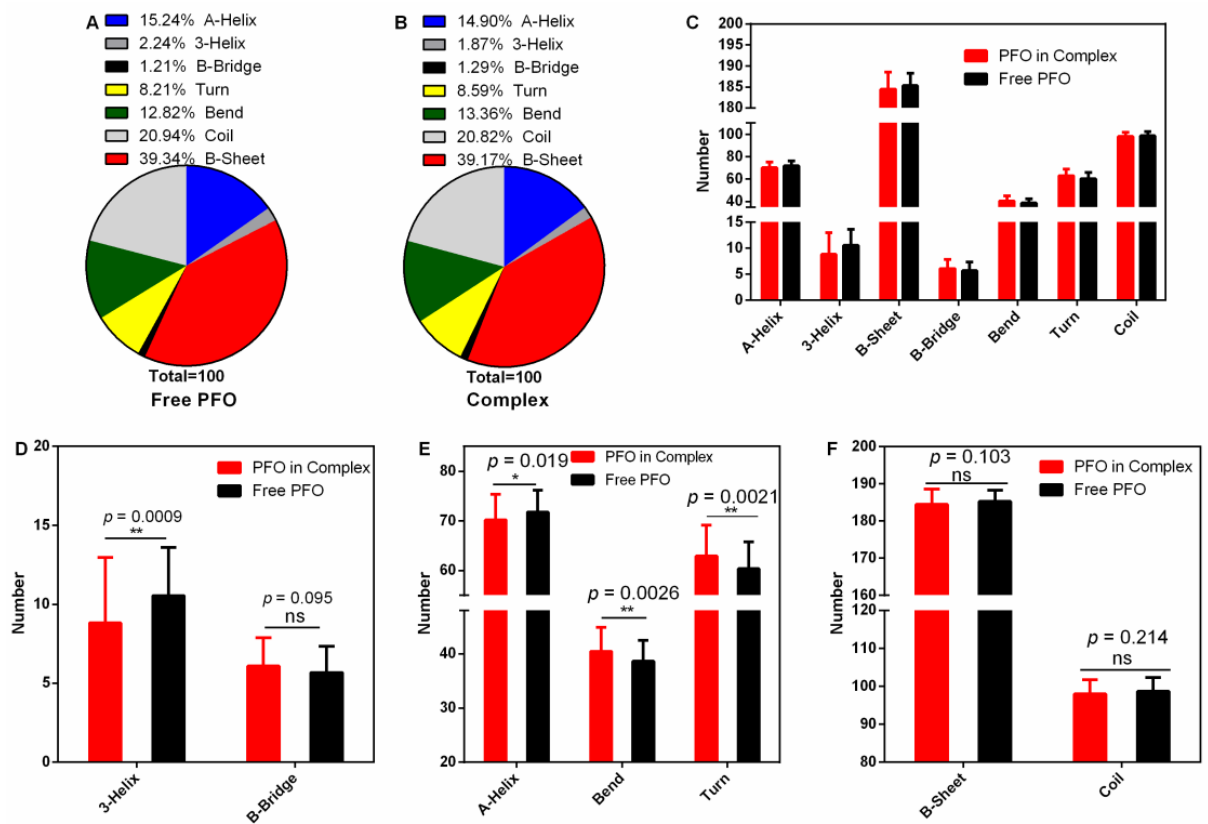
Figure 6. Secondary structure analysis during the stable stage. ( A , B ) The percentages of secondary structures in the free PFO and complex systems. ( C ) The numbers of secondary structures in the free PFO and the complex system. ( D ) The numbers of 3-helices and B-bridges in the free PFO and the complex system. ( E ) The numbers of A-helices, bends and turns in the free PFO and the complex system. ( F ) The numbers of B-sheets and coils in the free PFO and the complex system.